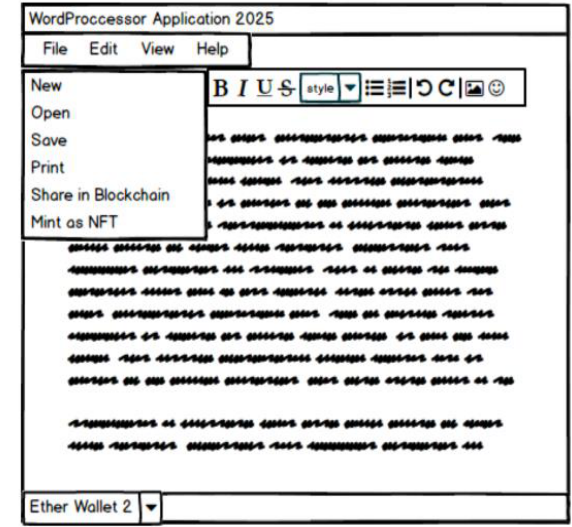
Figure 3. This UI facilitates using blockchain